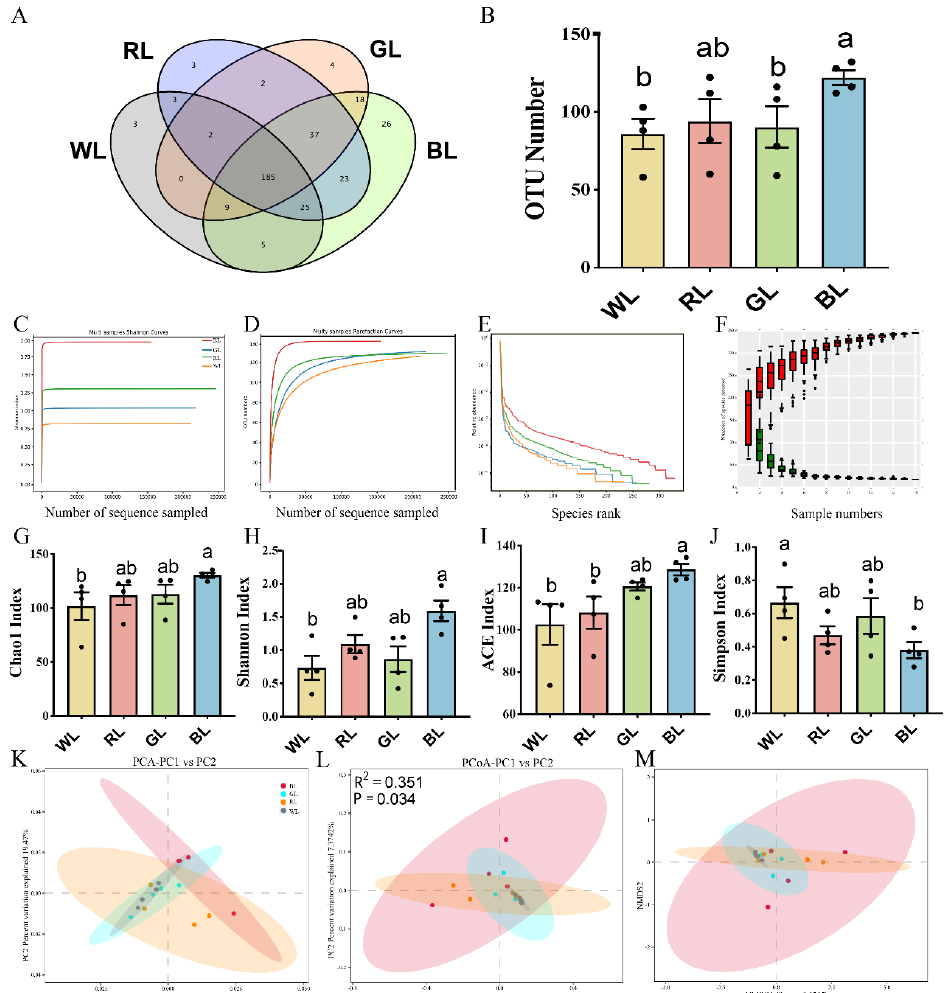
Figure 1. Effects of different monochromatic lights on the OTU number ( A , B ), Shannon curves ( C ), rarefaction curves ( D ), OTU rank curves ( E ), rank abundance curve ( F ), Chao1 index ( G ), Shannon index ( H ), ACE index ( I ), Simpson index ( J ), principal component analysis (PCA) ( K ), PCoA score plot ( L ), nonmetric multidimensional scaling (NMDS) score plot based on the weight UniFrac score plot based on the OTU ( M ) of the gut microbiota in the jejunum of WL, RL, GL and BL at P42. WL: white light; RL: red light; GL: green light; BL: blue light. These results are shown as means ± SEM. Differences between the four groups are presented in the form of different letters ( p < 0.05).